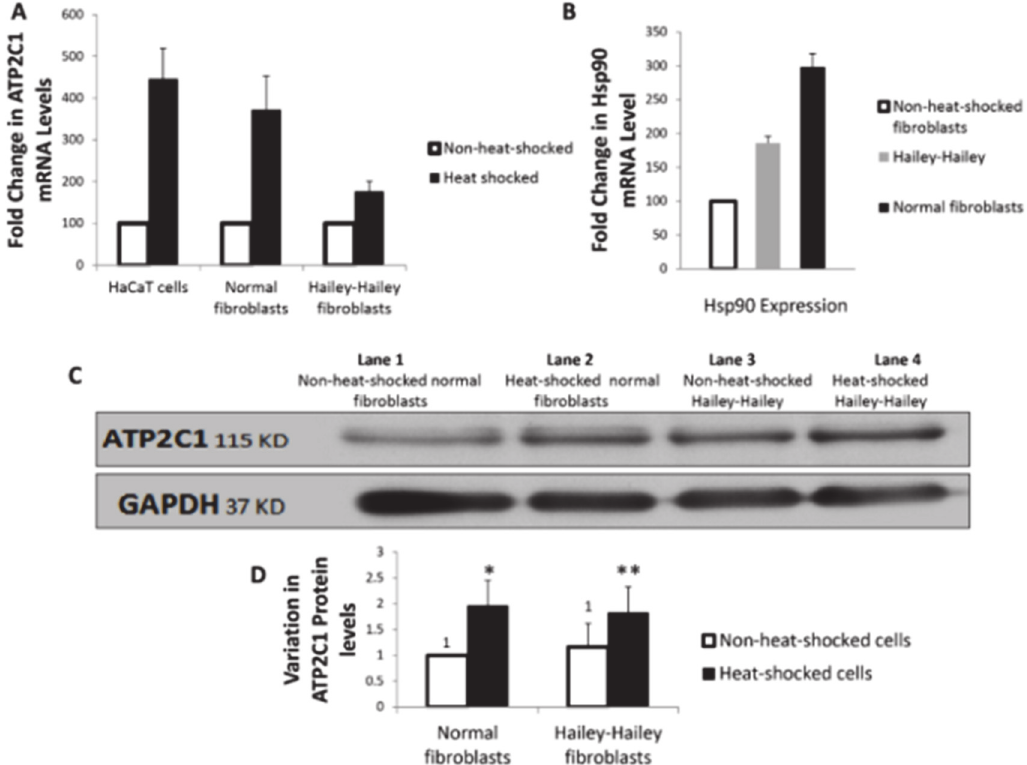
Fig 2. Heat-shock induces overexpression of ATP2C1. (A) Real-time PCR effects of heat-shock on HaCaT cells (p value = 0.004), fibroblasts from HH patient (p value = 0.003), and normal fibroblasts (p value = 0.01). (B) Hsp90 variation in expression before and after heat-shock in different cell types. (C) Western blot results; lane 1: non-heat-shocked normal fibroblasts, 2; heat-shocked normal fibroblasts, 3; non-heat-shocked Hailey-Hailey fibroblasts, 4; heat- shocked Hailey-Hailey fibroblasts. (D) ATP2C1 protein quantification (using image J software) based on the densities of the bands over GAPDH obtained through western blotting showing significant increase in normal fibroblasts ( * p value = 0.01), and non-significant increase in HH fibroblasts ( ** p > 0.05).